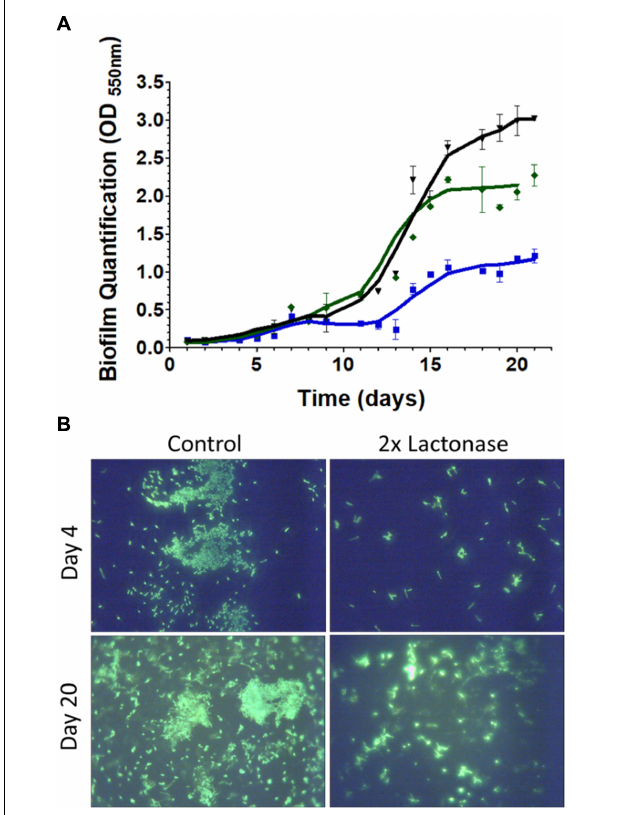
FIGURE 3 | Presence of lactonase reduces biofilm formation of the microbial community in the bioreactors. (A) Bioreactor parameters over the time course of the experiment (21 days). Measurements (duplicates) were performed on the three distinct bioreactors equipped with different filtration cartridges: the 2 × lactonase cartridge, containing only lactonase beads (blue line), the control cartridge containing only control beads (dark line), and the 1 × lactonase cartridge containing a 1:1 ratio of lactonase beads and control beads (green line). Biofilm quantification in submerged wells as quantified by crystal violet binding measured at 550 nm. (B) Glass slips submerged in the bioreactors were stained using SYBR gold DNA stain and visualized using a 60 ×